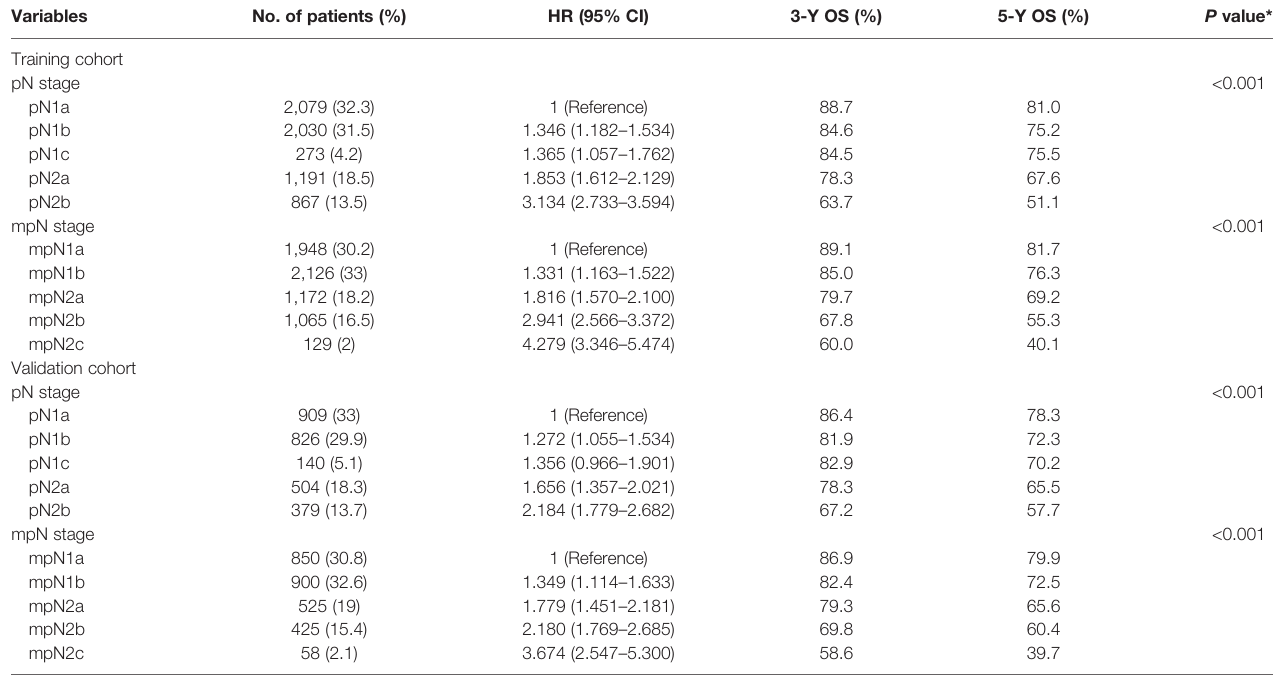
TABLE 5 | Three- and 5-year OS and 95% CI for pN stage and mpN stage in the training and validation cohorts. Variables No. of patients